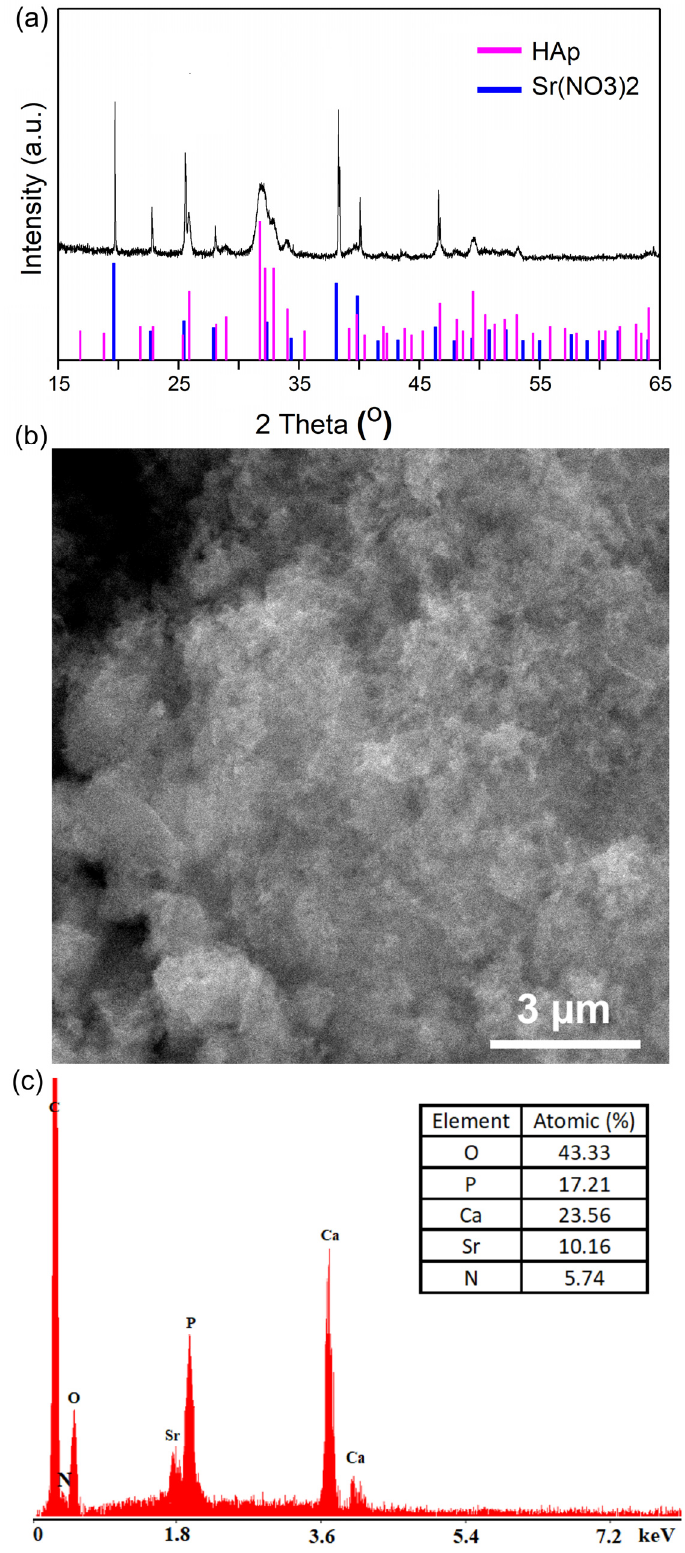
Figure 3. XRD patterns ( a ), SEM micrographs ( b ) and EDX spectra ( c ) of synthesized powder after removal of strontium ions from contaminated solution.